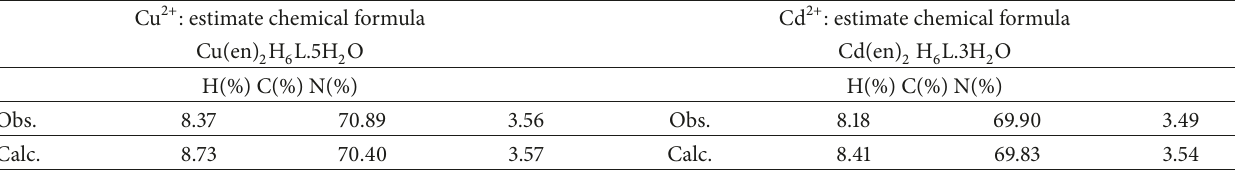
Table 2: Elemental analysis of Cu 2+ -H 8 L and Cd 2+ -H 8 L complexes and estimated chemical formula. Cu 2+ : estimate chemical formula Cd 2+ : estimate chemical formula